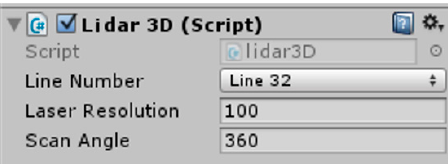
Figure 7. Program page of the 3D LiDAR script.